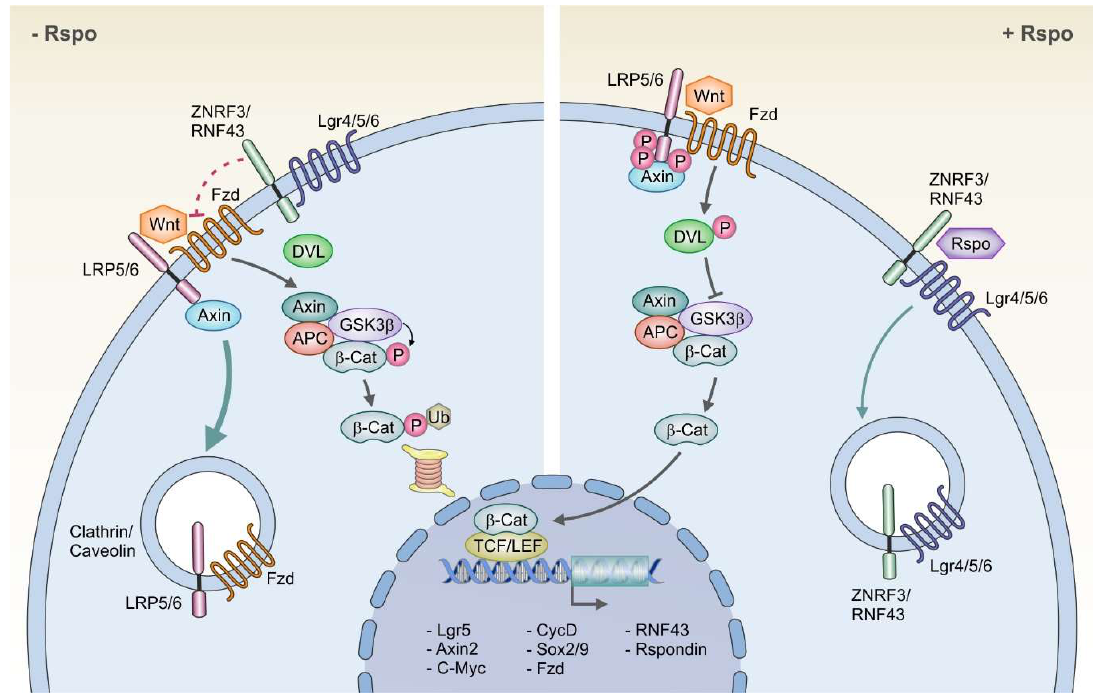
Figure 1. The Wnt and R-spondin signaling pathway: In the absence of R-spondin (-Rspo), the membrane ubiquitinase zinc and ring finger 3/ ring finger 43 (ZNRF3/RNF43) associates with the Wnt receptor complex Frizzled/ Low-density lipoprotein receptor-related protein 5/6 ( Fzd/LRP5/6), inducing its internalization and preventing its Wnt dependent phosphorylation, thereby inhibiting the downstream Wnt signaling cascade. In the presence of R-spondin (+Rspo), the ubiquitinase ZNRF3/RNF43 is internalized, enabling Wnt dependent phosphorylation of LRP5/6 and Dishevelled (DVL) as well as inhibition of glycogen synthase kinase-3 beta (GSK3beta). This then leads to the stabilization of the transcription factor beta-catenin (β-cat), its translocation in the nucleus and the subsequent expression of Wnt target genes.